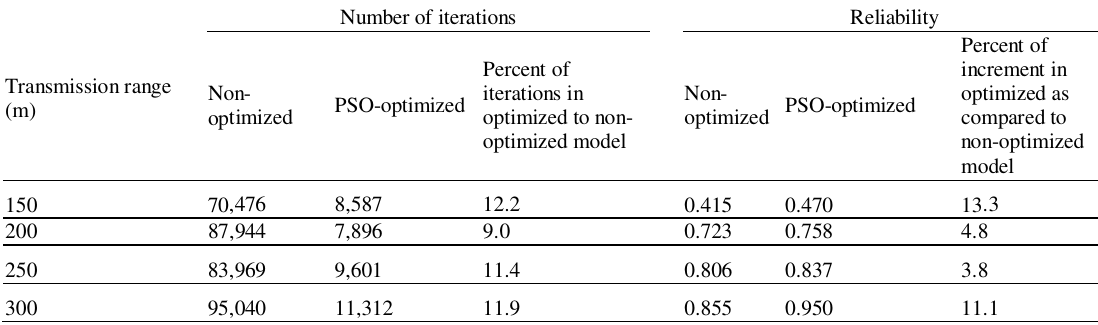
Table 6. Performance comparison between PSO-optimized and non-optimized HNN algorithms.